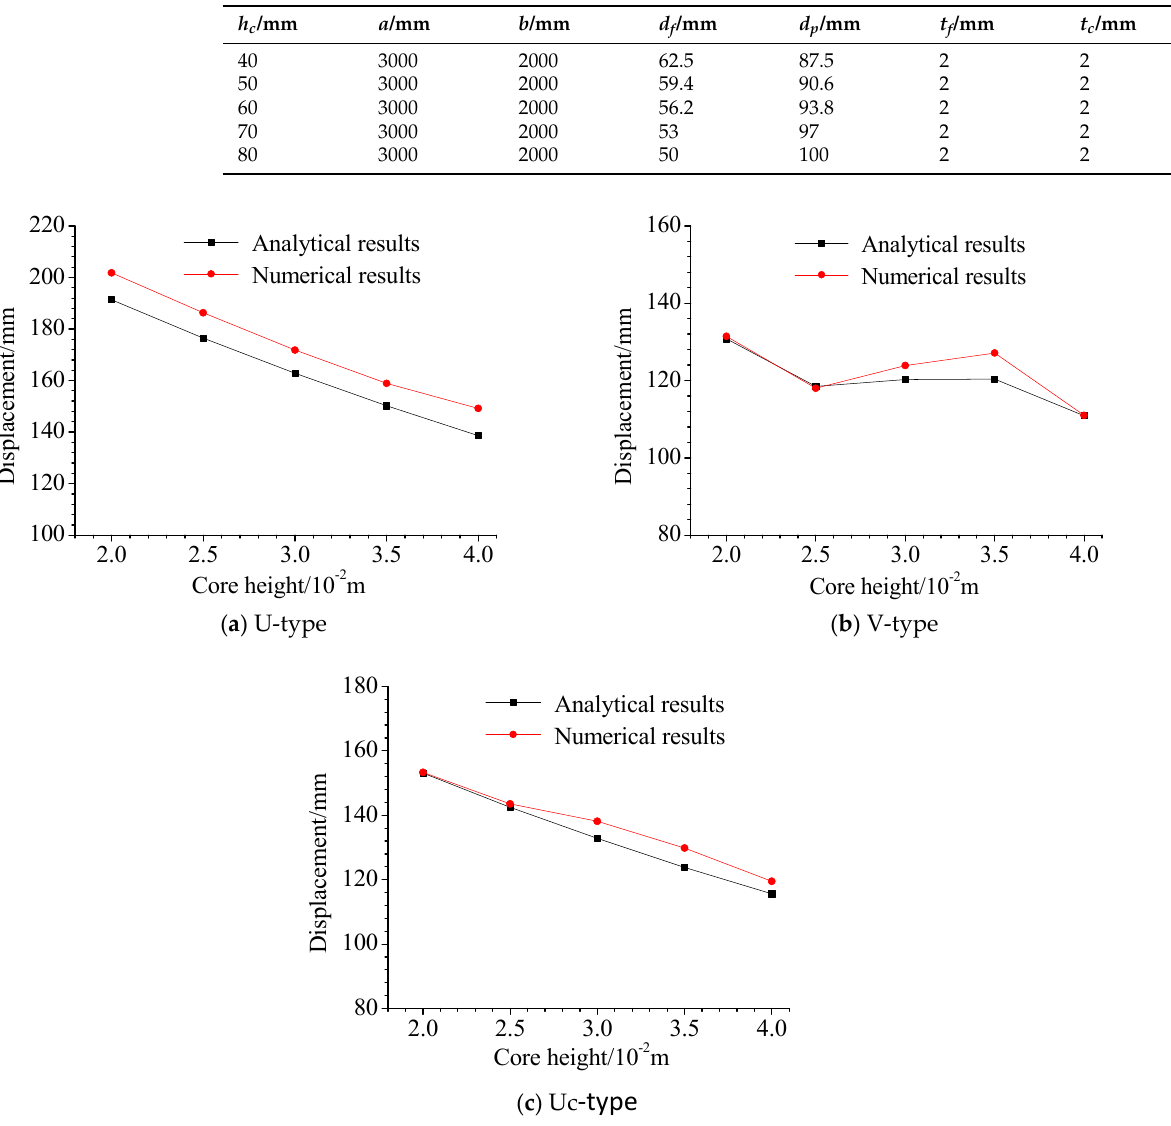
Table 8. Geometric parameters of the V ‐ type corrugated sandwich panel with different core heights.